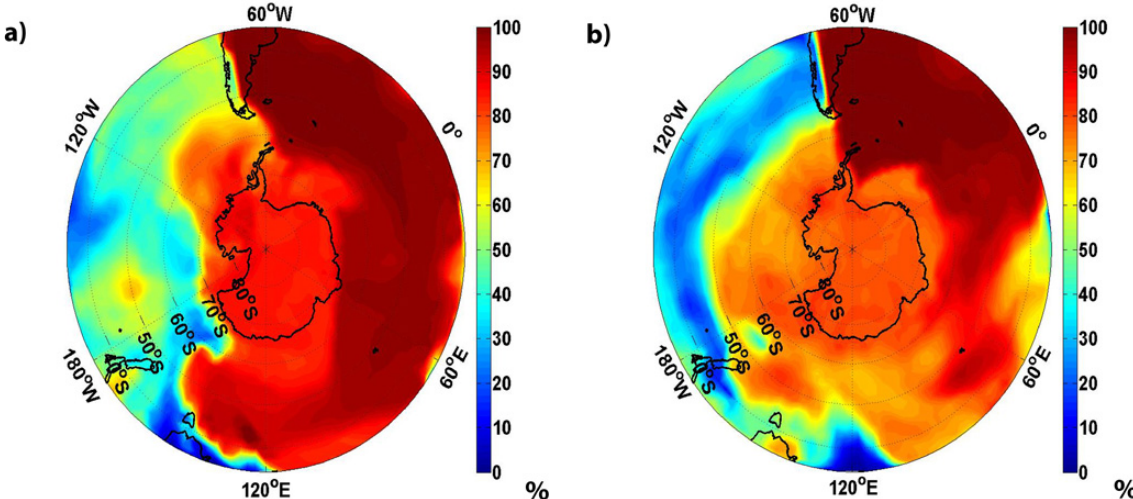
Fig. 7. The 8-day averaged GEOS-Chem-predicted percent contributions of Patagonian dust sources to total mineral dust deposition in the HNLC waters of the SO for the (a) J23 and (b) F11 dust